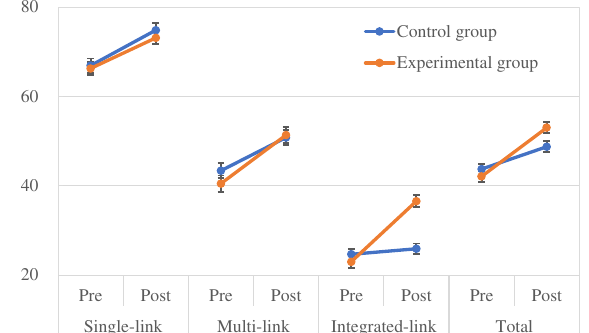
FIG. 4. Pretest and post-test performances of students in the control and experimental groups for three question sets. The error bars represent the standard errors of the means.